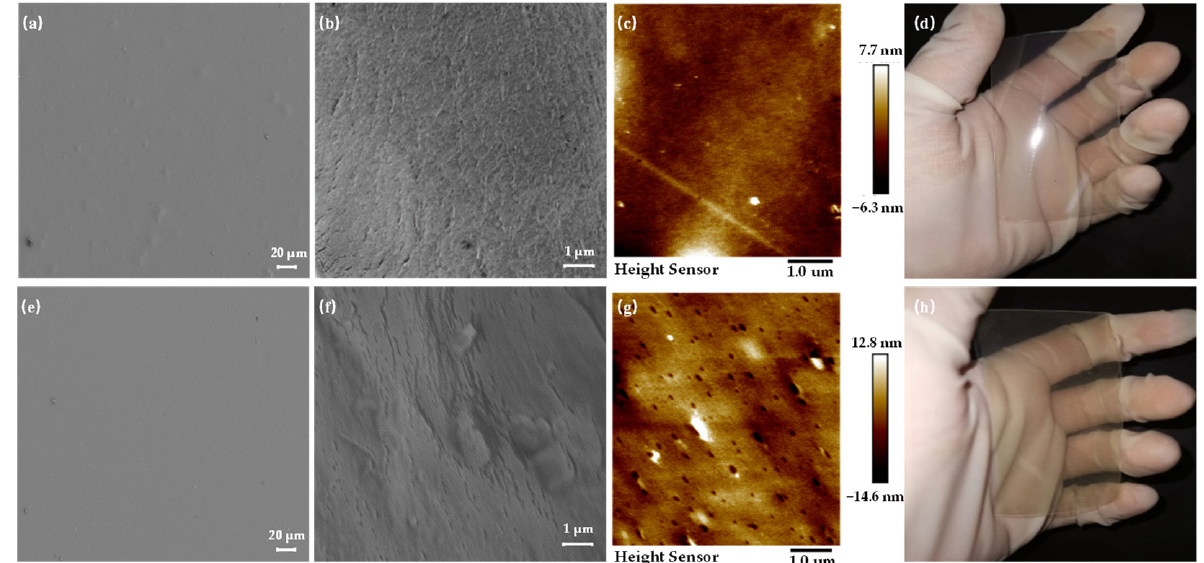
Figure 2. ( a ) SEM surface morphology, ( b ) SEM cross-section, ( c ) AFM surface morphology, ( d ) physical image of N212, ( e ) SEM surface morphology, ( f ) SEM cross-section, ( g ) AFM surface morphology, ( h ) physical image of the RM.